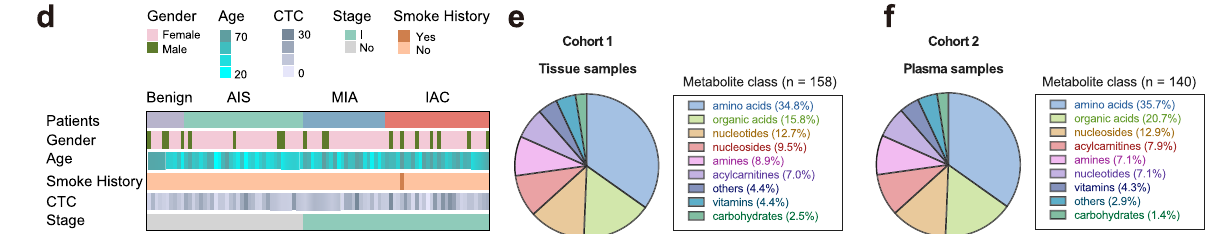
Fig. 1 Schematic overview of the study. a Overview of the study design. The illustration was created with BioRender.com. b Eight morphological stages from lung preneoplasia to invasive adenocarcinoma. c , d Clinical parameters of the study cohort 1 ( c ) and cohort 2 ( d ) were indicated in the heatmap. DFS, disease-free survival; OS, overall survival; CTC, circulating tumor cell (FU/3 mL). e , f Classes and counts of metabolites detected in cohort 1 (tissue samples) and cohort 2 (plasma